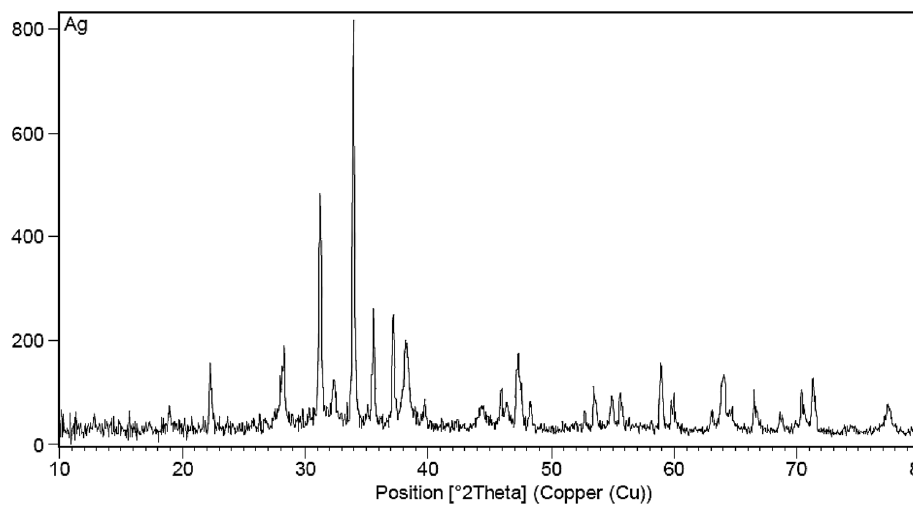
Figure 2. XRD analysis of prepared RA/Ag